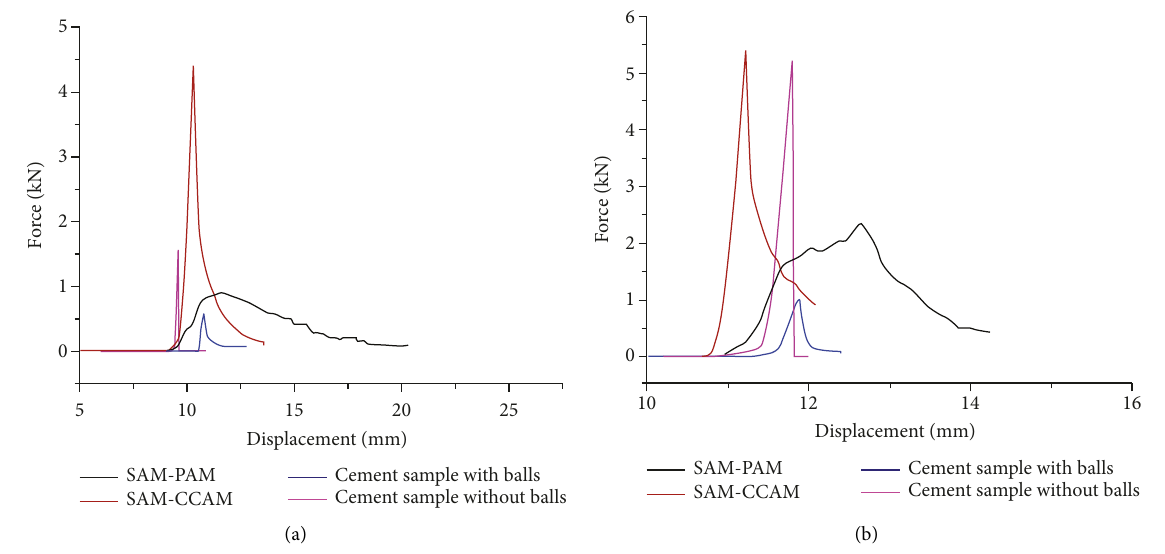
Figure 12: Force-displacement curves of samples from the SCB test. (a) 25 ° C. (b)